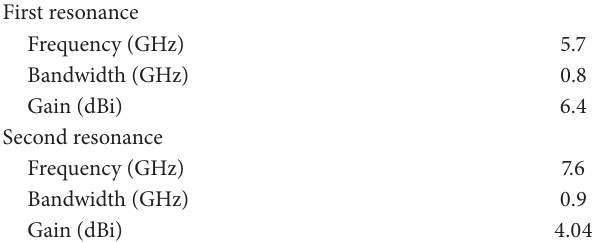
Table 1: Performance of the antenna at resonance